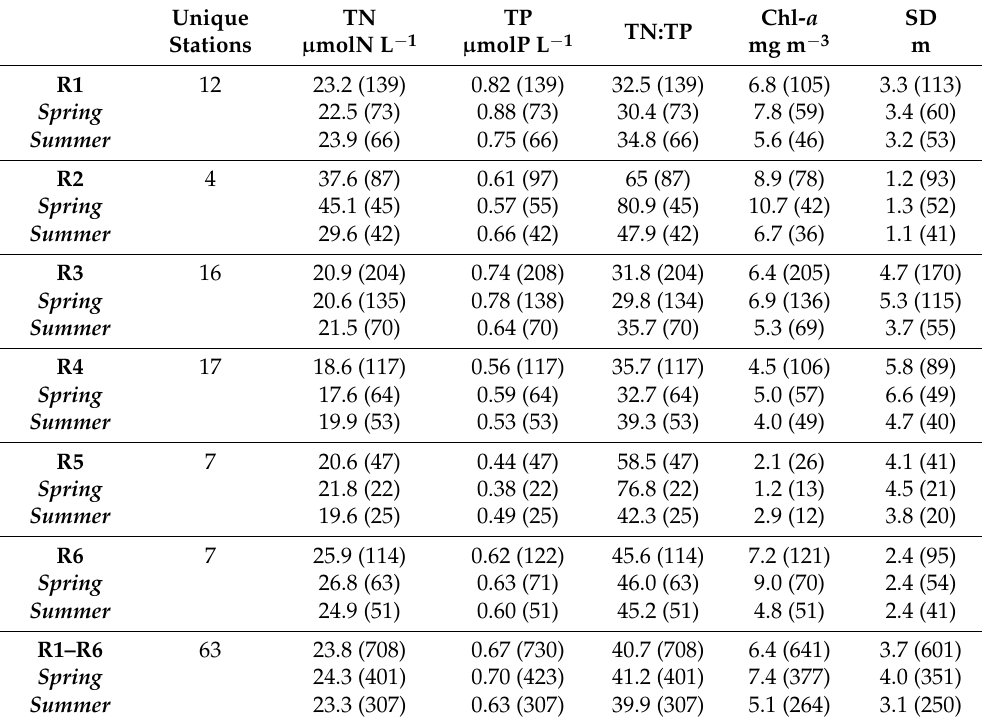
Table 4. The number of in situ unique sampling stations in different Estonian coastal regions (R1–R6), the in situ mean values for total nitrogen (TN), total phosphorus (TP), TN:TP ratio, chlorophyll- a concentration (Chl- a ), and Secchi disk depth (SD) in April to September, spring (April to June), and summer (July to September) of the match ups during 2016–2021. The number of measurements is shown in the